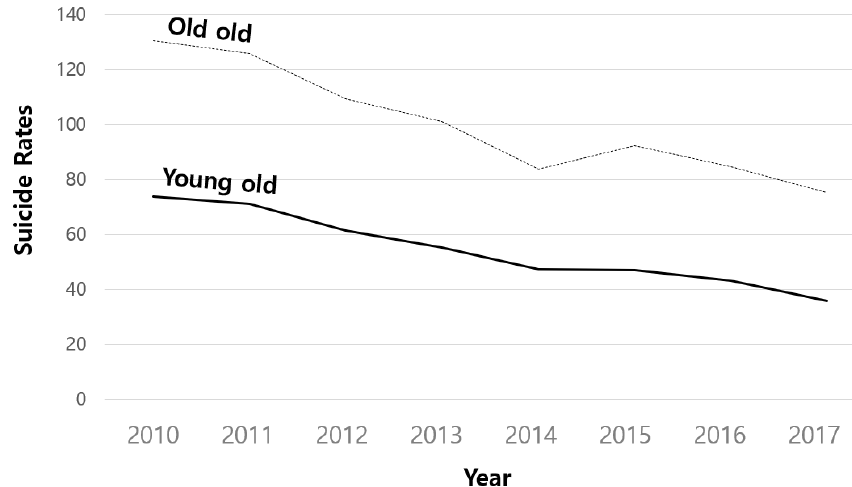
Figure 2. Suicide rate of older adults by age.